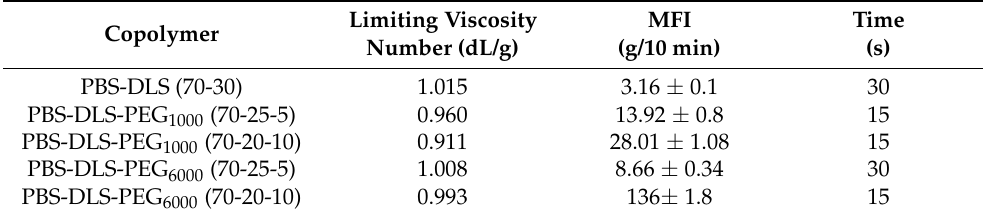
Table 3. Intrinsic viscosity (limiting viscosity number) and melt flow index (MFI) of the synthesized copolymers with different amounts of PEG 1000 and PEG 6000 .